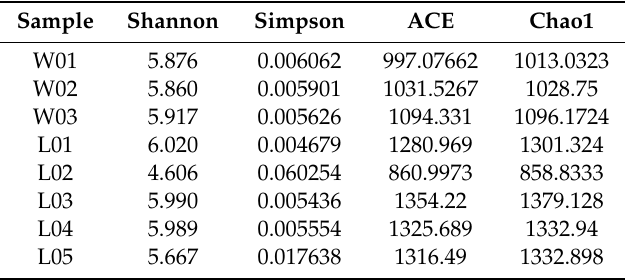
Table 3. Soil bacterial diversity index based on 16S rDNA